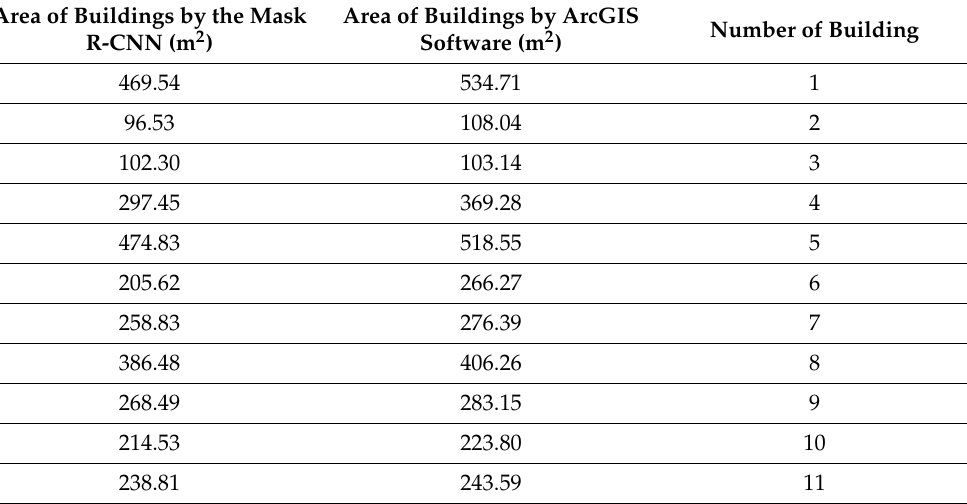
Table 5. Comparison of buildings area between the mask R-CNN results and reference data from China. Area of Buildings by the